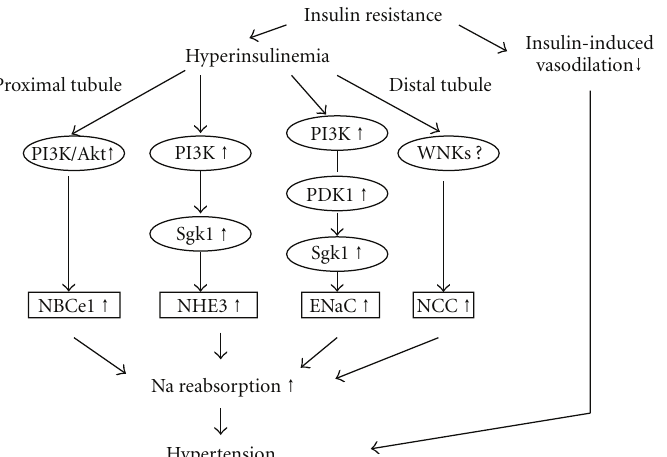
Figure 2: Mechanism of hypertension in insulin resistance. In insulin resistance, insulin-induced vasodilation is impaired. However, insulin induced sodium reabsorption through various nephron segments seems to be preserved or